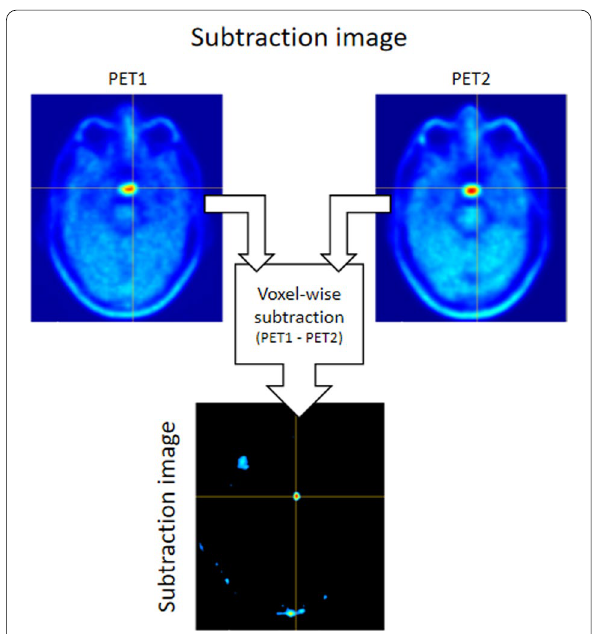
Fig. 3 Subtraction imaging techniques. Subtraction images are created by performing a voxel-wise subtraction of the second (suppressed) Met-PET scan from the first baseline Met-PET